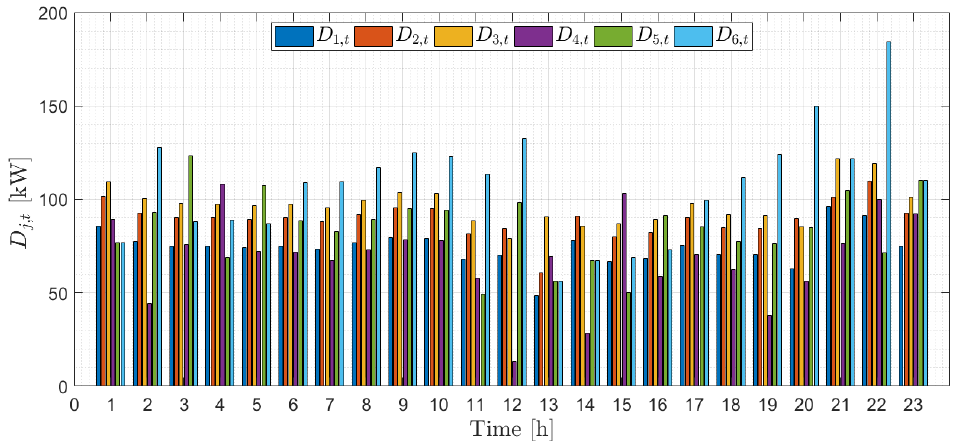
Energies 2019 , 12 , x FOR PEER REVIEW Figure 8. Values of the power exchanged by the LUs and the main grid. Figure 8. Values of the power exchanged by the LUs and the main grid.